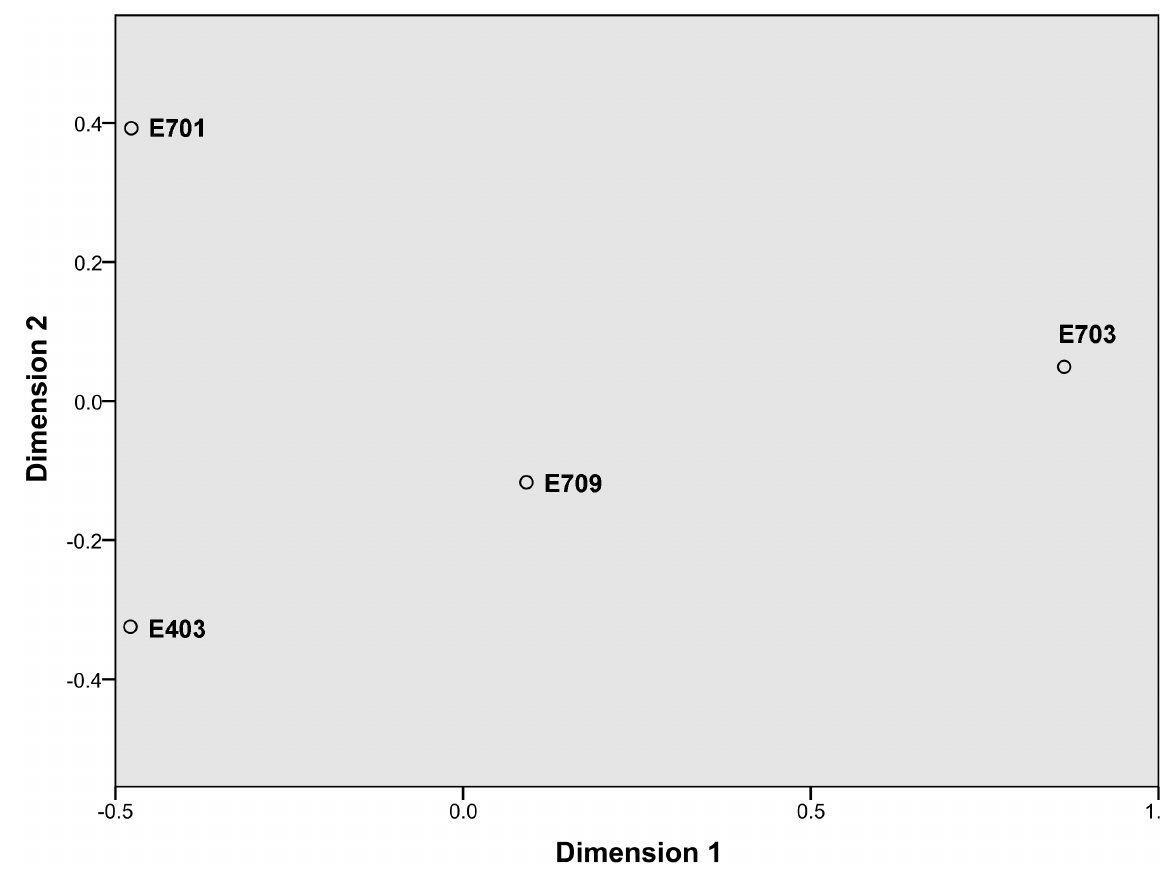
Figure 5. Two-dimensional plots of MDS analysis from g5 gene clone library to compare broad-scale differences between Rhodobacterales communities.